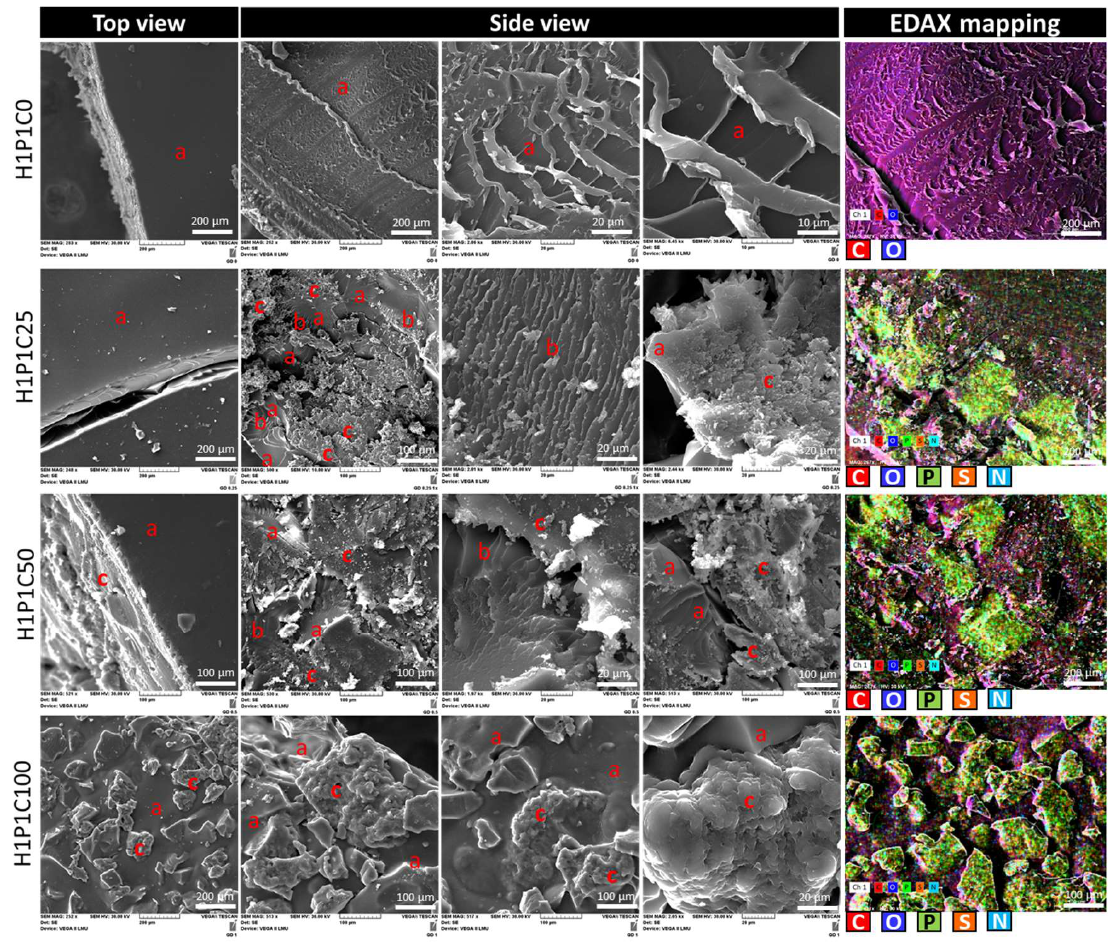
Figure 2. Representative SEM micrographs revealing microstructural features of the H1P1C25/50/100 hybrids with increasing casein content. Amorphous H1P1C0 hydrogel was used as a control. First image in each raw—top view; the other three SEM micrographs display side view images taken from the cross-sections (a—amorphous synthetic hydrogel, b—porous interface between synthetic and casein, c—casein micelles); 5th column—representative EDAX mapping showing the distribution of casein (overlapping areas rich in N, P and S) in the synthetic matrix containing C and O (cross-section view, colour code assigned for each representative element).